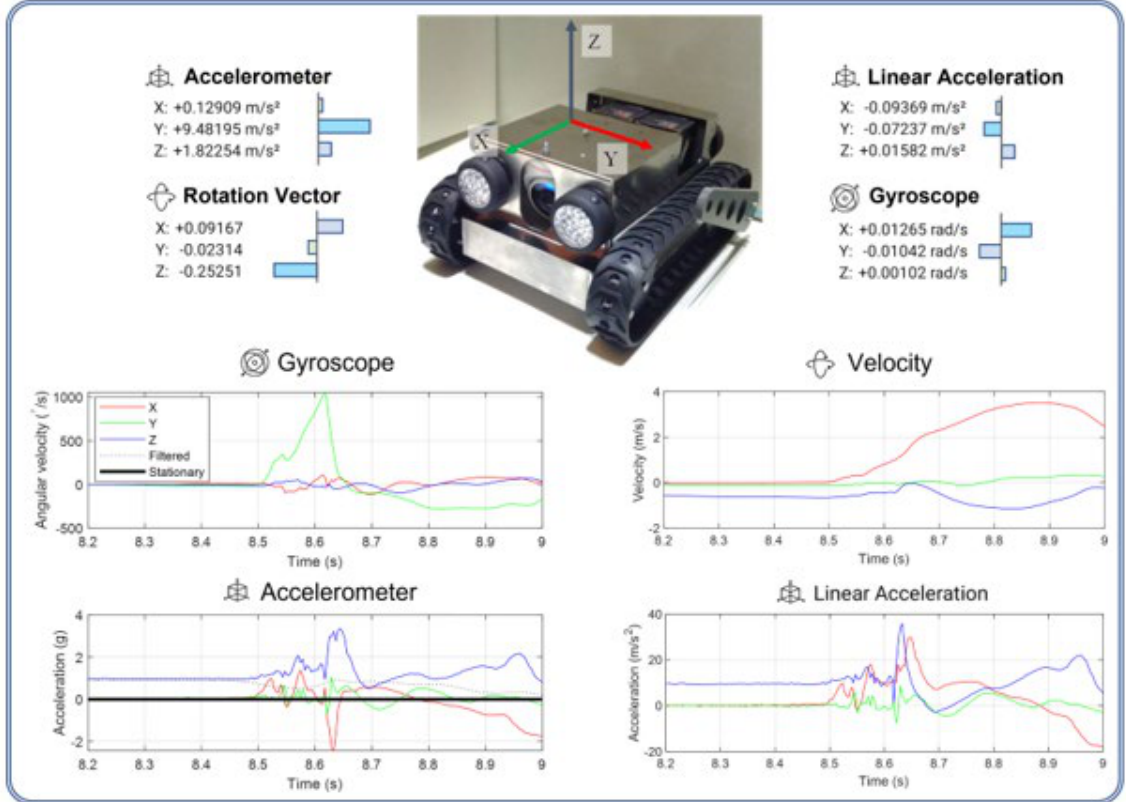
Figure 12. HMI for the visualization of the internal sensor suite.